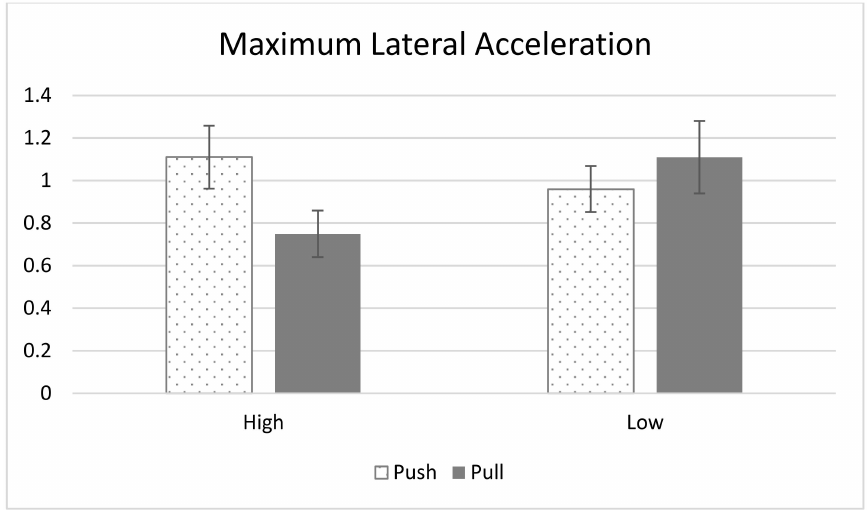
Figure 3. Maximum Lateral Acceleration ( p < 0.05) [error bars indicate standard errors]. Table 6. Takeover performance